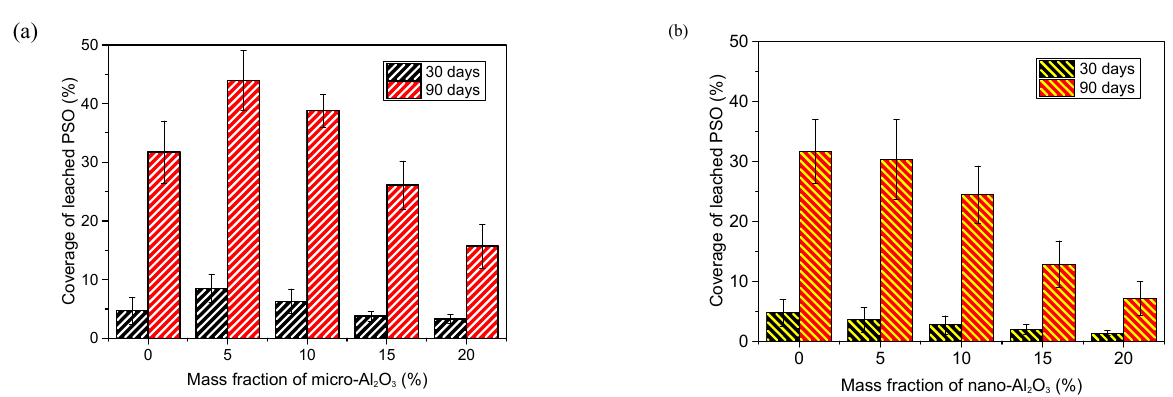
Figure 6. Effect of alumina on leached PSO: ( a ) Micro-alumina, ( b ) Nano-alumina.